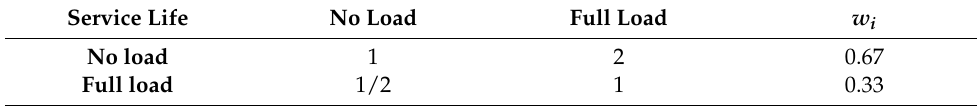
Table 21. Important judgment matrix for service life under different operating conditions.